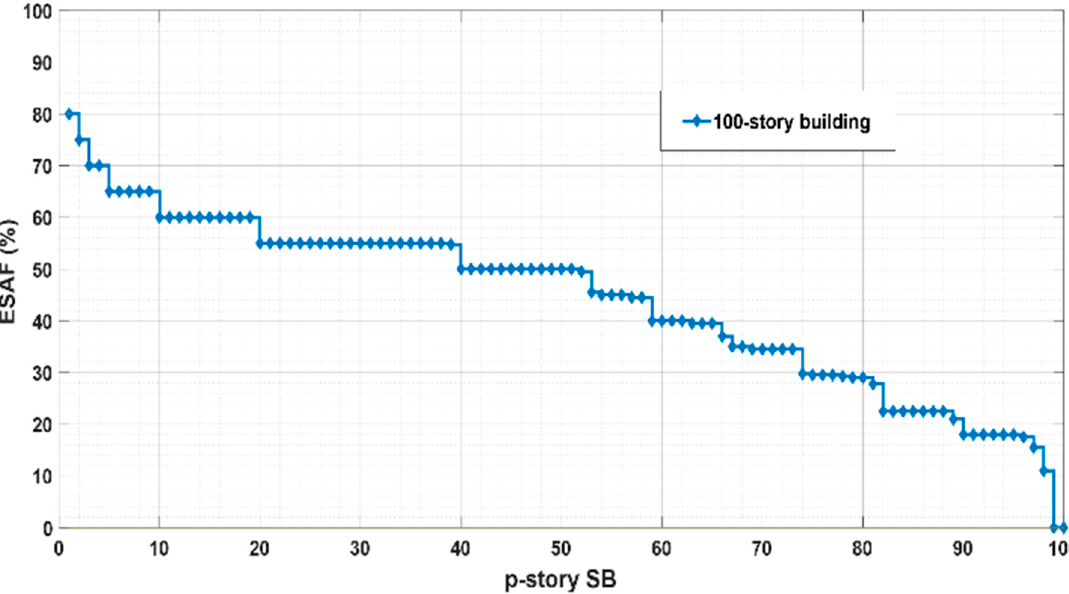
Figure 12. ESAF behavior for a 100-story SB, d = 1 Km.